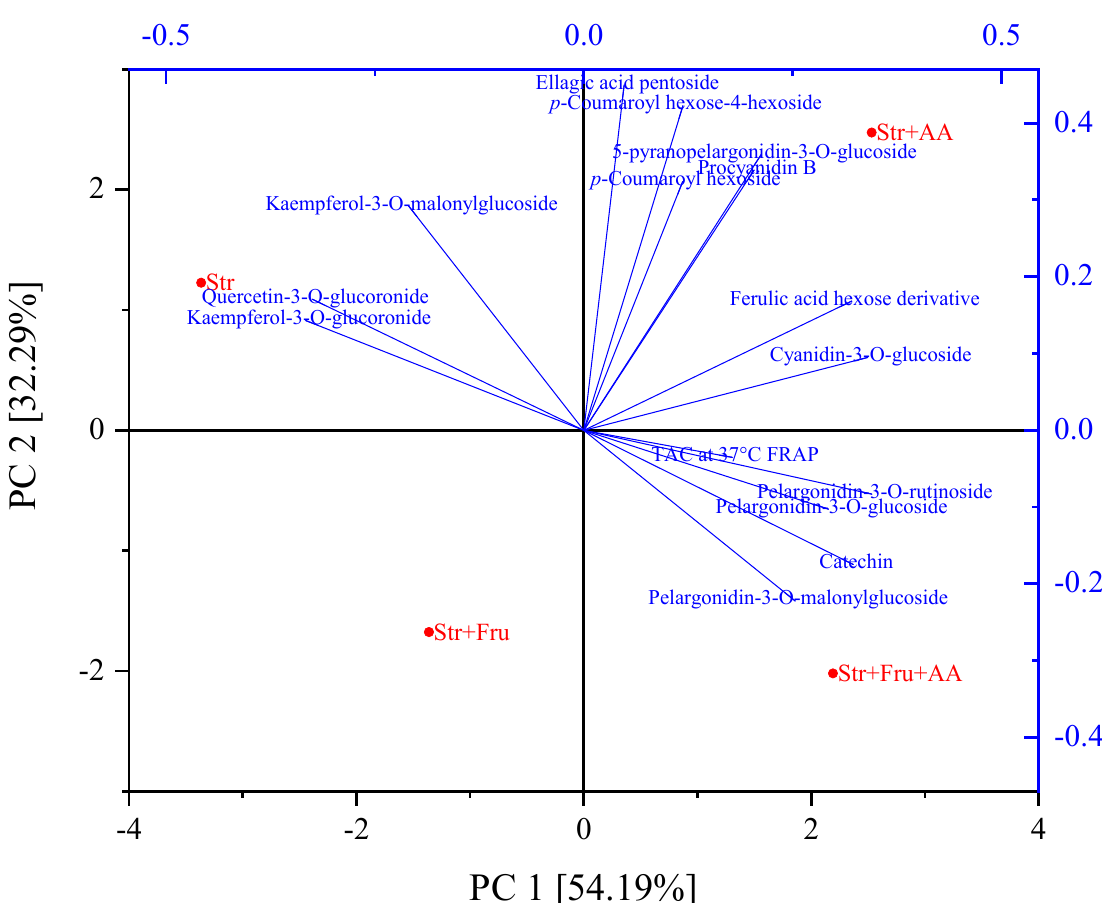
Figure 6. Principal component analysis (PCA) of degradation rate constants during shelf-life experiment at 37 °C of polyphenols and the TAC, in citric buffer pH = 3, 50 mM with different formulations: Str—strawberry, Fru—fructose and AA—ascorbic acid. Polyphenols were quantified using HPLC-MS and TAC was measured using FRAP. Degradation rates were calculated assuming first-rate order. * p -Coumaroyl hexoside and procyanidin B are overlapping in the PCA.